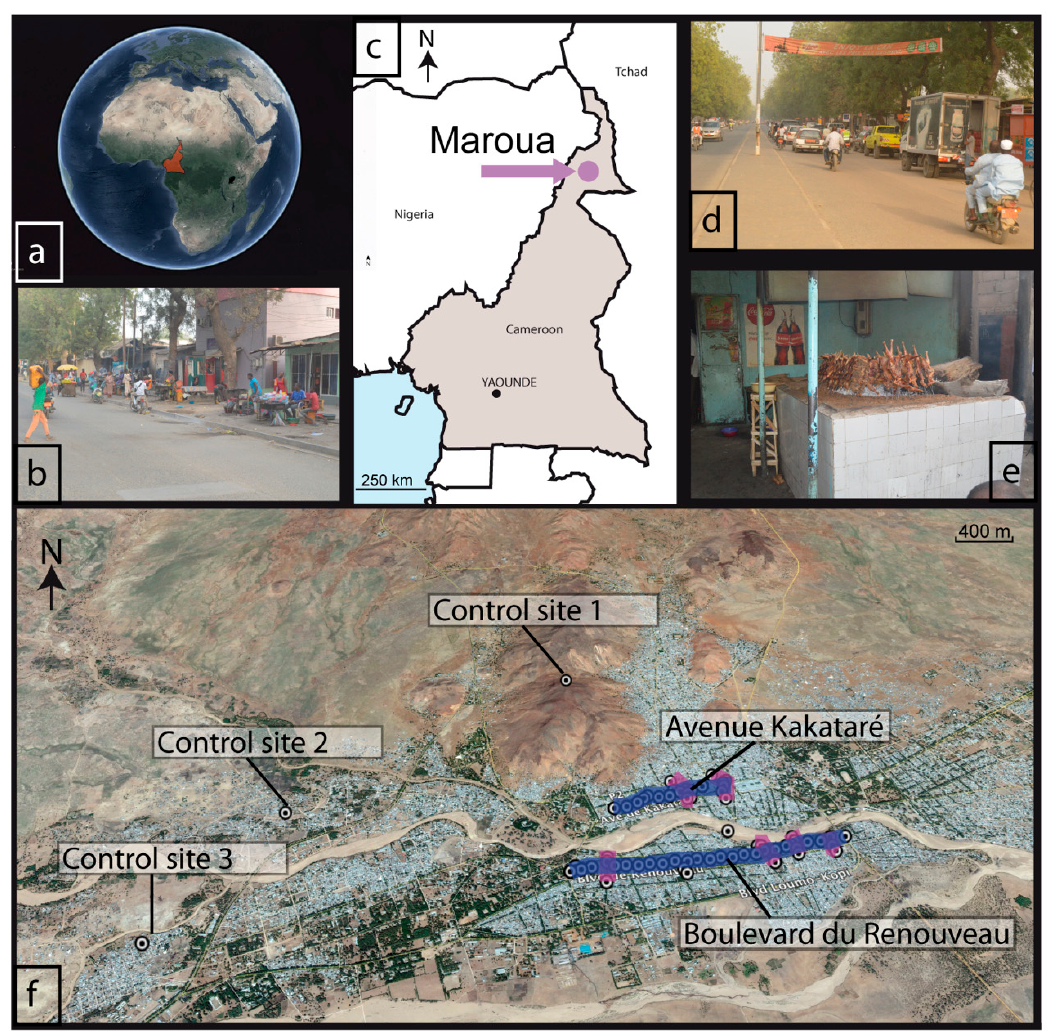
Figure 1. Localization of sampling sites modified from @Google Earth ( a , c , f ) and photographs (@ Daouda Dawai ) illustrating anthropogenic activities in the streets of Maroua, Cameroon ( b , d , e ).